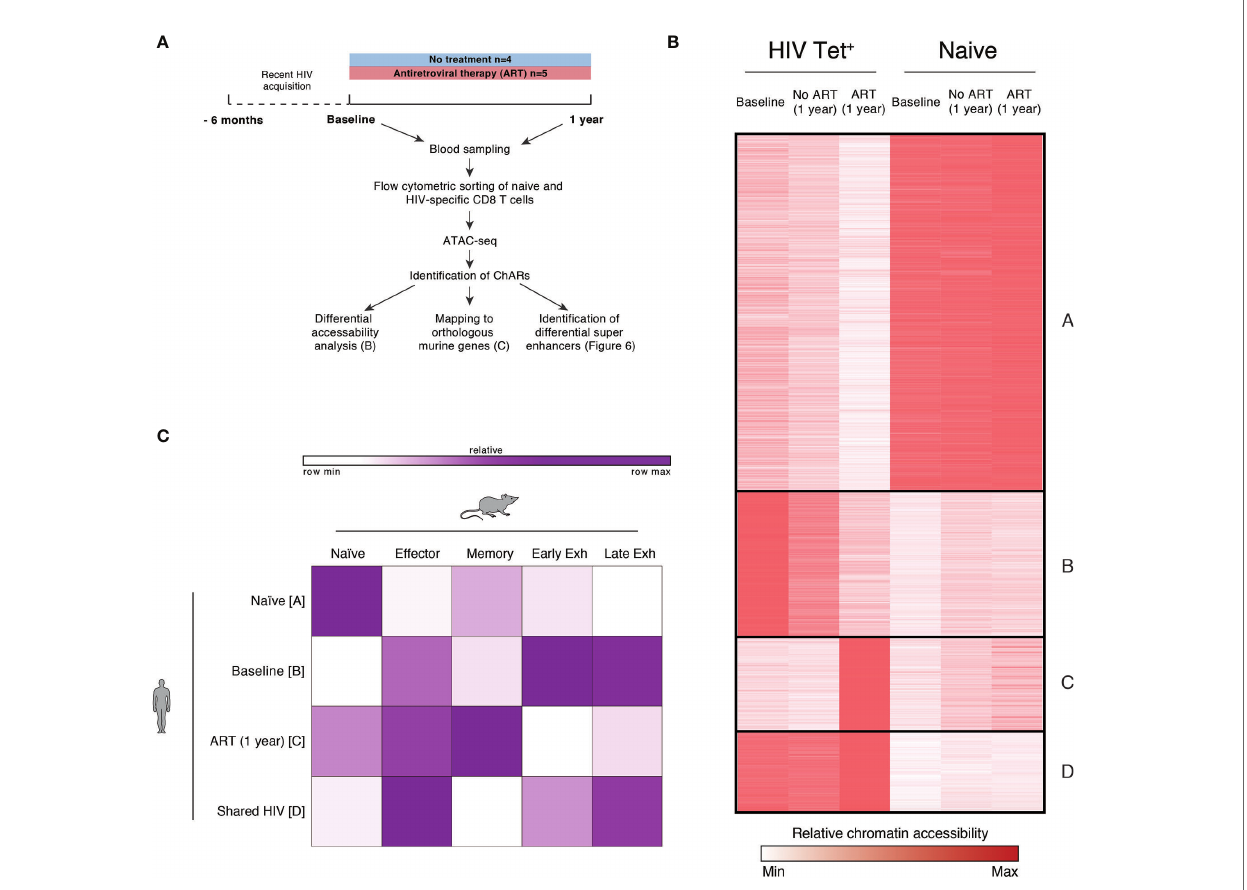
FIGURE 5 | HIV-speci fi c CD8 T cells exhibit exhaustion-associated epigenetic changes during PHI but not following 1 year of ART. (A) Schematic outlining the experimental setup used for the epigenetic pro fi ling of naïve and HIV-speci fi c CD8+ T cells. (B) k-means clustered heatmap of chromatin accessibility within modules of chromatin accessible regions (ChARs) (rows) showing 81,138 regions (out of a total universe of 172,174) that were differential at an FDR threshold < 0.05 between at least one of all possible pairwise comparisons. The quantitative differential analysis was run using all samples that passed QC and individual patients as biological replicates; for the construction of this heatmap values for each condition was averaged across the patients. Values have been row normalized to account for the fact that different open chromatin regions can have different baseline accessibilities. (C) Fold enrichment of regions orthologous to mouse naïve, effector, memory and exhaustion enhancers in human in clusters identi fi ed in B, which are most prominent in naïve (cluster A), or HIV-speci fi c CD8 T cells at baseline (cluster B), following one year of ART (cluster C) or in both conditions (cluster